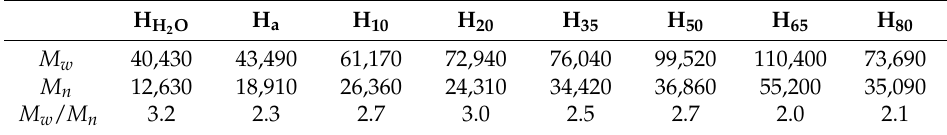
Table 2. Weight-average ( M w ) and number-average ( M n ) molecular weights and polydispersity ( M w / M n ) of the hemicellulosic fractions isolated from sweet maize